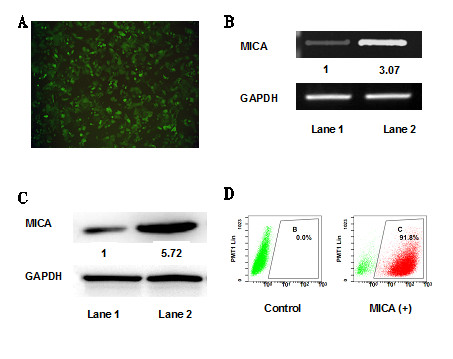
Establishing of MICA-transfected human corneal epithelium.
MICA-transfected corneal epithelium cells were labeled with GFP
(A). MICA RT-PCR products (B) and protein (C)
from the control vector alone (Lane 1) and MICA-transfected cells (Lane
2) were both detected at 48 h after transduction. RT-PCR and
western-blot analysis both show an increase in MICA expression in the
transduced cells compared to the control cells. Flow cytology showed a
high MICA positive rate for these transfected cells (D). Original
magnification: A × 40.